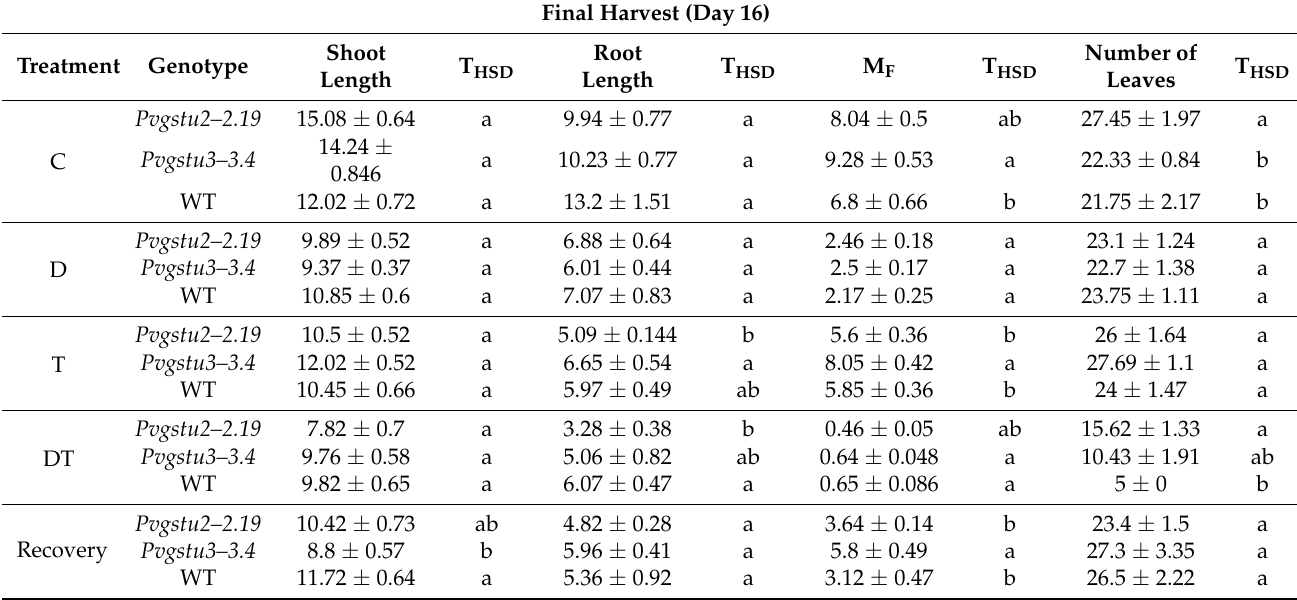
Table 2. Growth traits of Pvgstu transgenic lines and WT tobacco plants grown for 16 days in drought (D), heat (T), and combination of drought and heat (DT) stresses and their recovery measured on day 16. Tukey’s HSD (T HSD ) post hoc test was performed for the interaction effect of genotype × treatment on shoot and root length, fresh weight (M F ) and the number of leaves. Data are the mean ± SE (WT: n = 4; Pvgstu lines: n = 7). Different letters indicate significant differences between genotypes for each treatment at p <